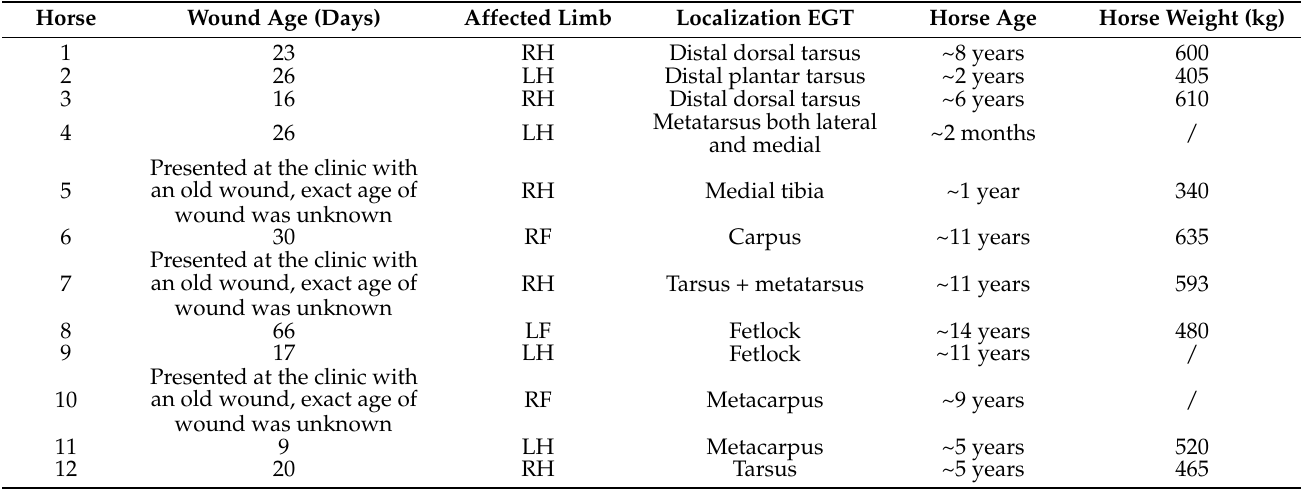
Table 1. Table with additional information on the exuberant granulation tissue-developing wounds. RH: right hindlimb; LH: left hindlimb; RF: right front limb; LF: left front limb.